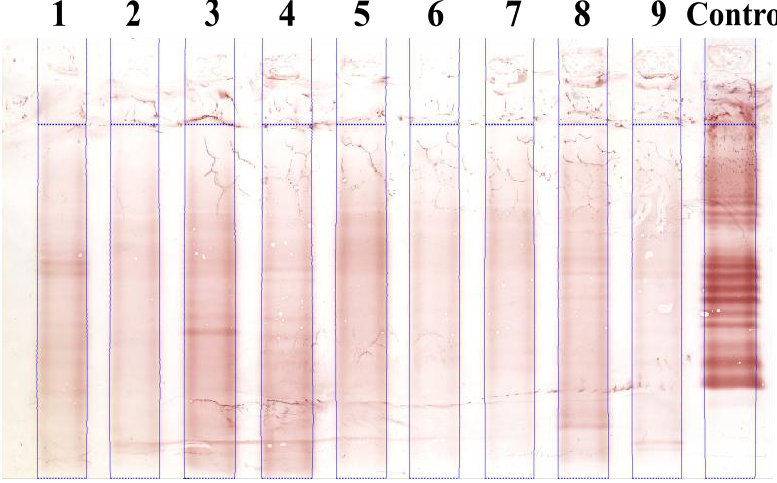
Figure 7. Illustration of a band-straightening result for the CSF membrane in Figure 1